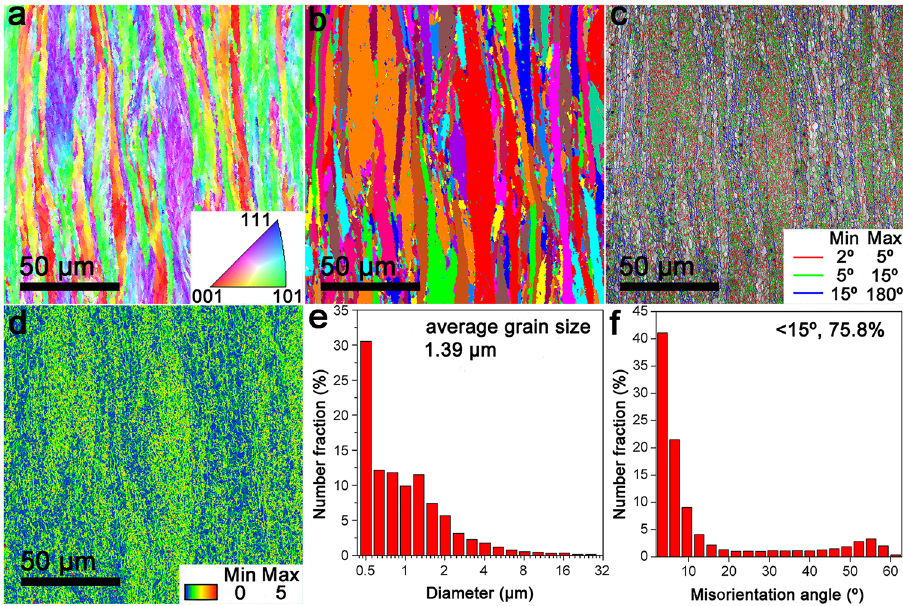
Fig. 3 Electron back-scattering diffraction (EBSD) characterization of W grains. a Inverse polar fi gure (IPF) map of cWY alloy showing W grains along the rolling direction are not preferentially oriented. b Corresponding grain map revealing most of W grains are strongly elongated and coarsened after HERF processing. c Grain boundary distribution map revealing a combination structure of small-sized sub-grains existing in elongated mother-grains in cWY alloy. d Kernel average misorientation (KAM) map revealing that the larger the grains are, the more defect density or the greater plastic deformation they possess. e Grain size distribution image and f Grain boundary misorientation distribution image of cWY